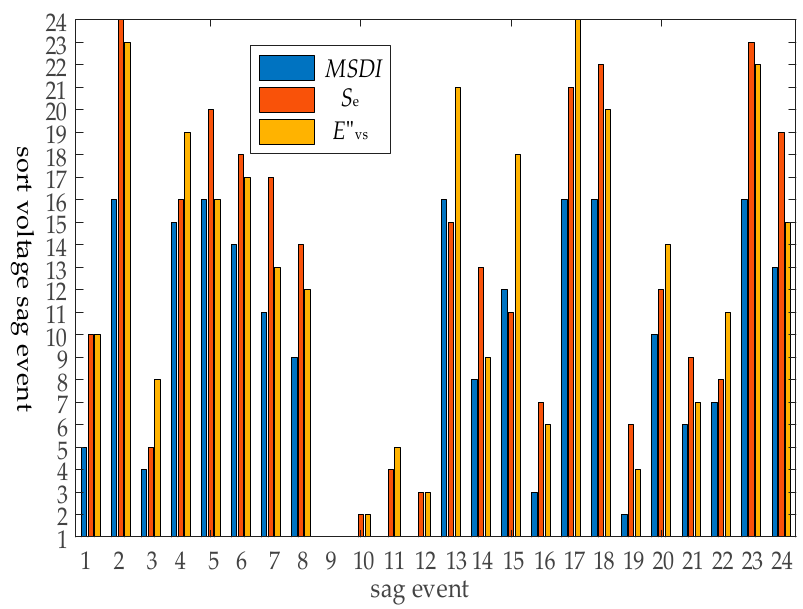
Figure 11. Comparison of severity ranking results under different evaluation indicators. Figure 10. Severity ranking comparison before and after improvement based on energy index. Figure 10 shows that the severity ranking curves of the sag events before and after the improvement of the energy index are basically the same, which indicates that the improved energy index, considering the equipment tolerance characteristics and the type of sag, is reasonable for evaluating the sag event. Among them, sag events 9, 10, 11, 12 and 19 are always in the front of the ranking, before and after the improvement of the energy index, and have a great impact on users and are equivalent to the fault abnormal region; sag events 2, 4, 6, 13, 15, 17, 18 and 23 are always at the back of the ranking, before and after the improvement of the energy index, and have little impact on users and are equivalent to the normal operation region. In addition, there are situations in which the severity ranking results of sag events change before and after the improvement of energy index: the ranking results of the severity of the sag event 16 and the sag event 21, before and after improvement, are opposite. This is because when the sag types of the two sags are the same, the influence factor of the sag amplitude is larger than that of the duration. That is, it is more realistic to consider the equipment tolerance characteristics. Similarly, the ranking results of the severity of the sag event 3 and the sag event 14, before and after improvement, are also opposite. This is because sag event 14 is a two-phase sag event occurring in region D, while sag event 3 is a single-phase respite event occurring in region C. In the same way, the change in the severity ranking results of sag event 7 and sag events 8, 22, and the change in severity ranking results of sag event 5 and sag event 20, can be analyzed, although this will not be repeated here.